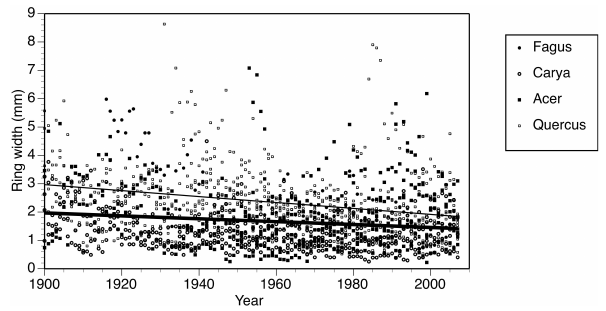
Fig. 5. Increments measured on four hardwood tree species at six sites. Separate linear regression lines are shown for Quercus (light) and the three other hardwood tree species